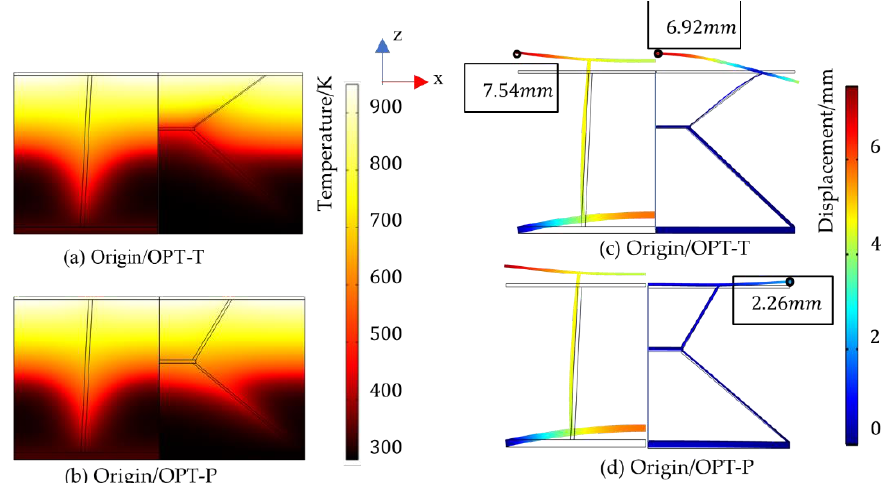
Figure 10. Thermal and mechanical response of the origin and optimized design. ( a ) Maximum temperatures of the TFSs, ( b ) maximum temperatures of the mid-points of the webs, ( c ) maximum tempertures of the BFSs and ( d ) maximum displacements of the TFSs.